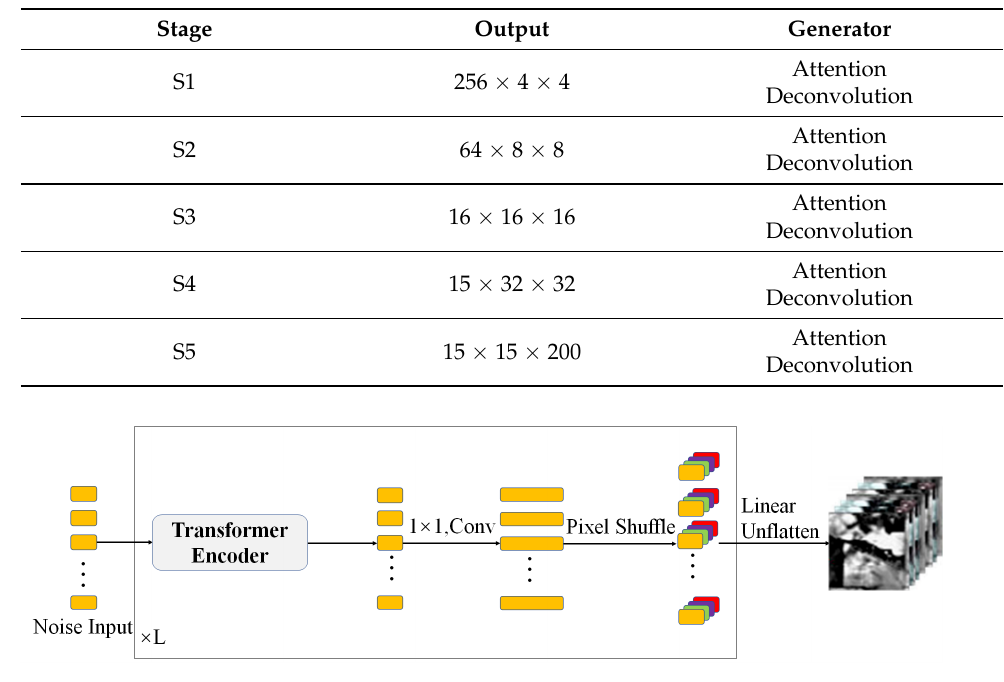
Table 3. The detailed structure of the Generator.